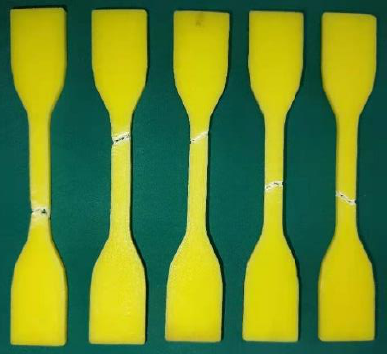
Figure 8. Samples after tensile testing. Figure 8. Sample s after tensile testing. Figure 8. Sample s after tensile testing.